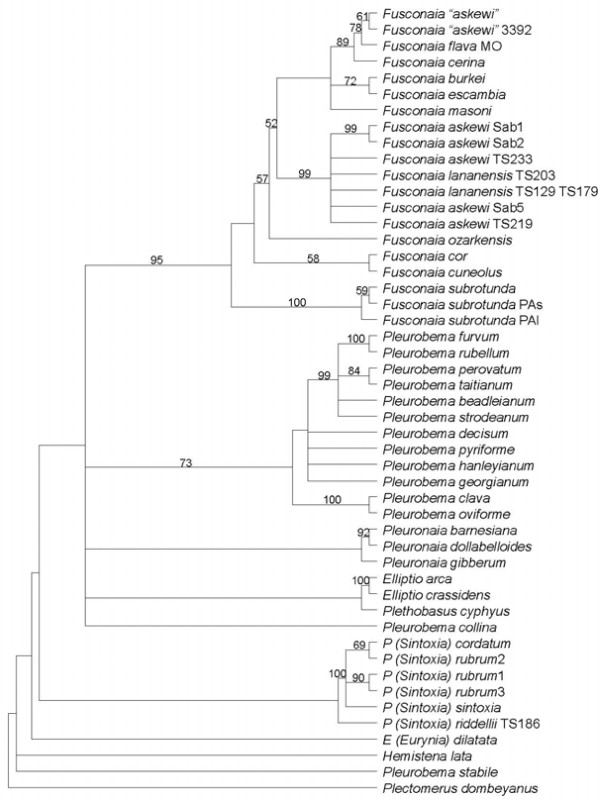
Strict consensus cladogram,nad1data, with jackknife percentages shown if over 50%.